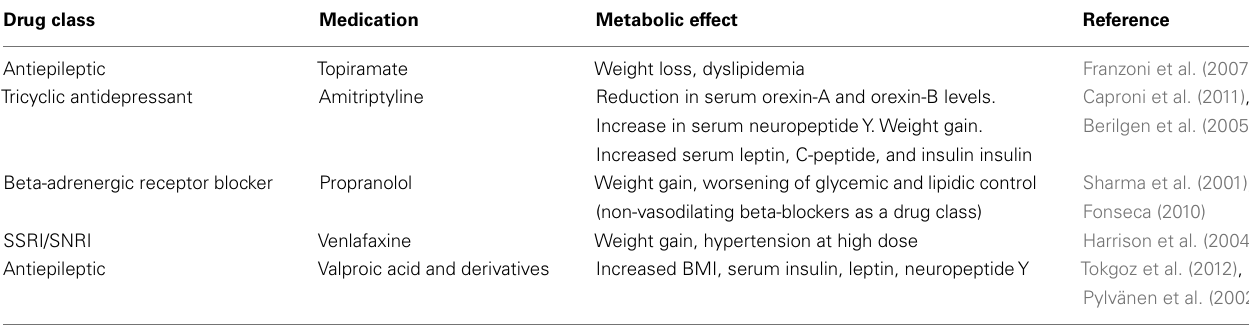
Table 2 | Select metabolic derangements found in migraine by migraine